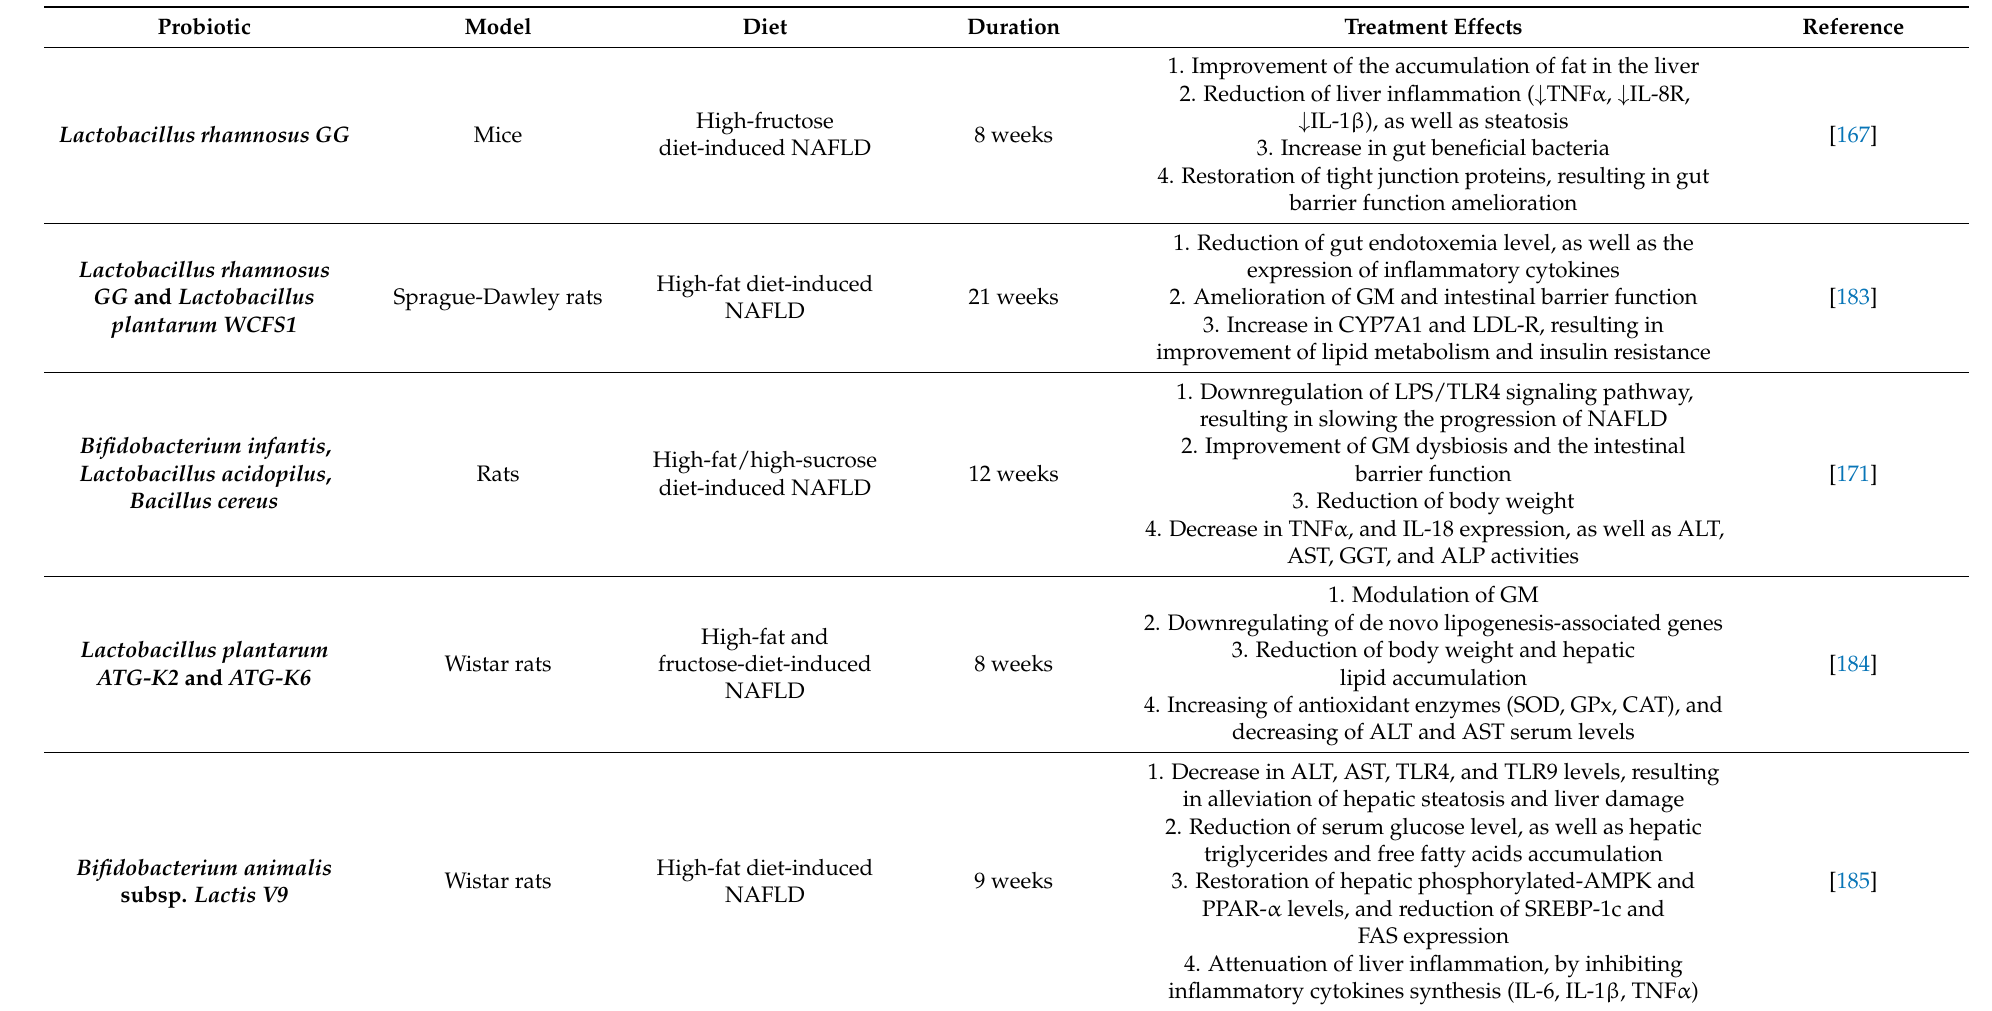
Table 3. Effects of probiotics treatment in animals and human experimental